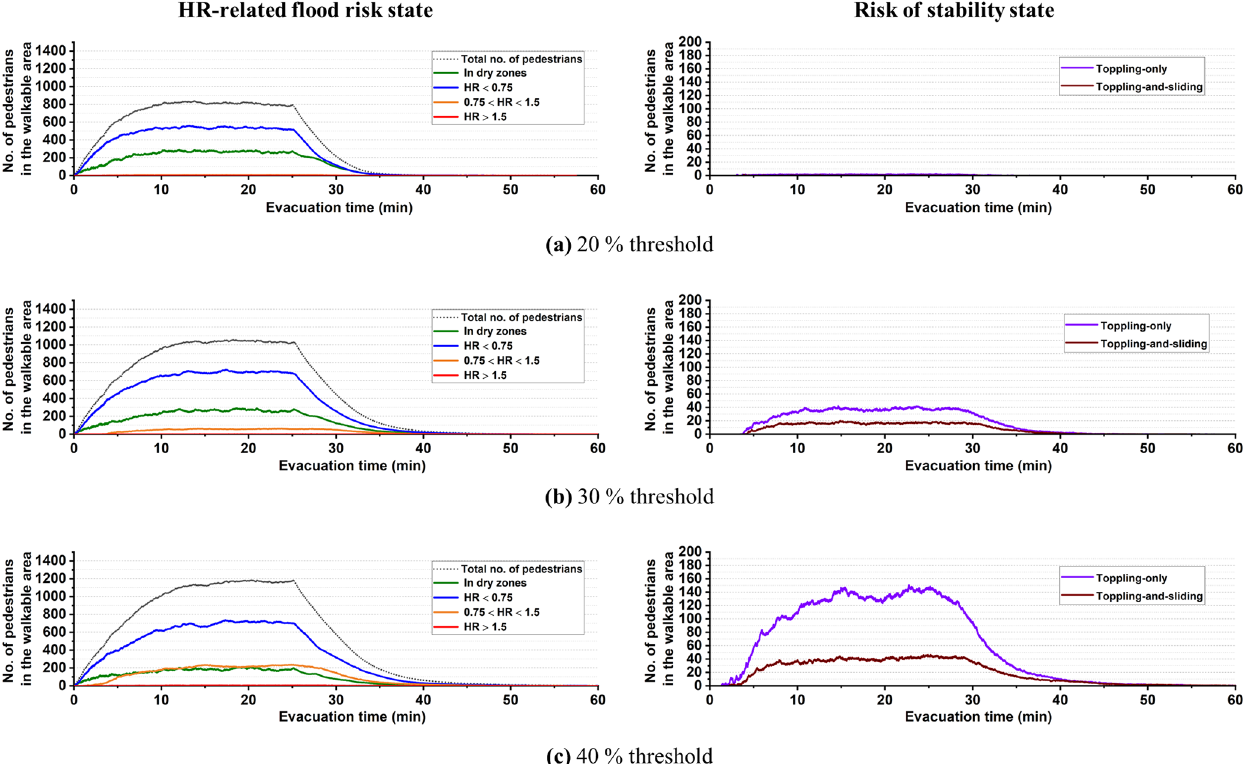
Figure 13. Total number of evacuating pedestrians in the walkable area plotted according to their HR-related flood risk state (left panel) and stability state when they were immobilised in floodwater (right panel) during the evacuation time: (a) 20% threshold, (b) 30% threshold, and (c) 40%